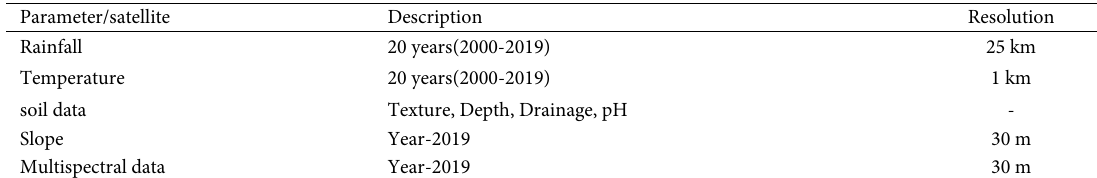
Table 1: Description of input parameters